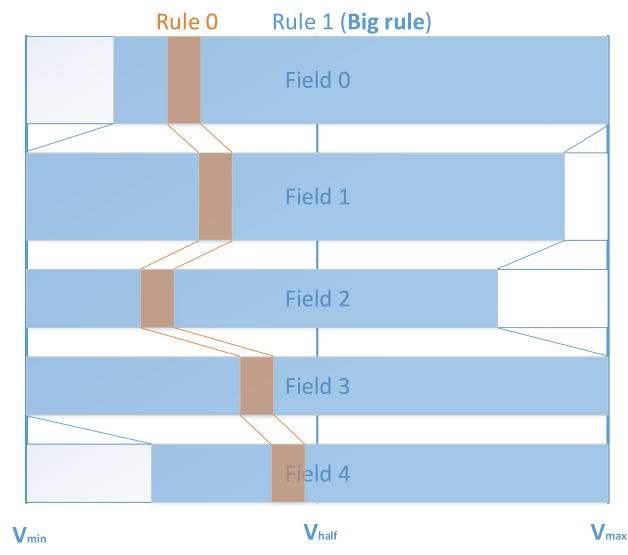
Figure 2. An example of One-big overlaps.